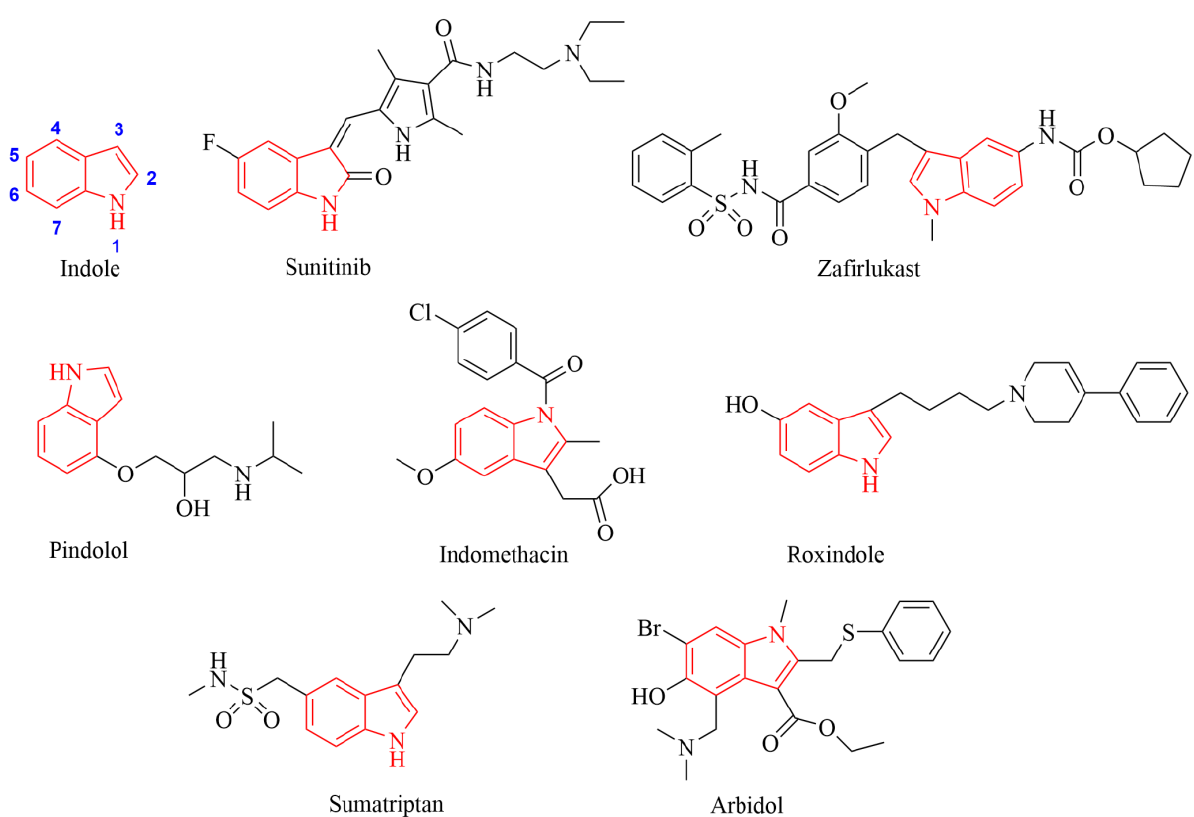
Figure 2. Chemical structures of indole and drugs having an indole scaffold. The indolin-2-one scaffold is present in the structure of suntinib (anticancer drug) (Figure 2), which inhibits the Fms-like tyrosine kinase-3 receptor (FLT3). This multi- directional tyrosine kinase inhibitor has an inhibitory effect on vascular endothelial growth factor VEGF, platelet-derived growth factor (PDGF), and c-KIT receptor kinases. Sunitinib is used to treat various types of cancer, such as renal cell carcinoma (RCC), gastrointestinal stromal tumor (GIST), pancreatic neuroendocrine tumors (pNET), non-small cell lung cancer (NSCLC), and thyroid cancer [23,24]. Drugs that contain a chemical indole moiety and are clinically applicable include zafirlukast (anti-asthma), pindolol (anti-hypertensive), indomethacin (an- ti-inflammatory), roxindole (anti-psychotic), sumatriptan (anti-migraine), and arbidol (antiviral) (Figure 2) [21,22,25–28]. The indole scaffold has been a highly beneficial motif for the development of agents effective against cancer, including the drug-resistant types [22,29]. The introduction of an